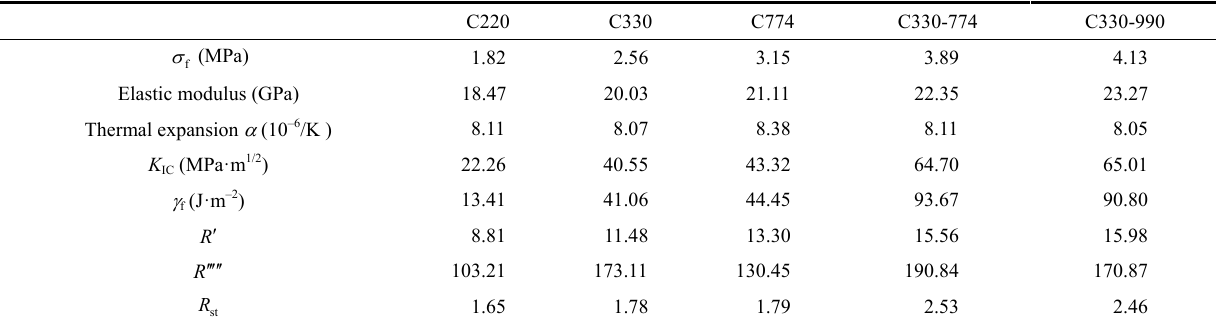
Fig. 5 Thermal shock resistance of porous alumina ceramics: (a) residual flexural strength and (b) residual strength ratio of specimens. Table 4 Parameters of thermal shock resistance of PAC with different types of carbon black at critical